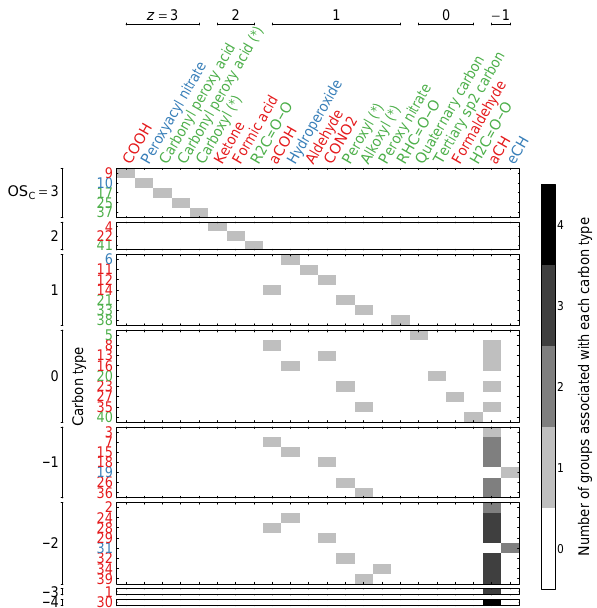
Figure 2. Visualization of the carbon type matrix (cid:50) for the APIN mechanism. Radical groups are denoted with (*). Carbon types and FGs are ordered by their aerosol abundance (in decreasing order) in the APIN simulation at t max SOA (Sect. 2.1) with each value of OS C and z , respectively. The numeric label for carbon types indicates the overall rank (without regard for its OS C ) in the APIN simulation at t max SOA . Formaldehyde and formic acid are subclasses of alde- hyde and COOH, respectively, but are defined separately to fulfill the conditions described in Supplement Sect. S1. Further details re- garding the FG definitions are provided by Ruggeri and Takahama (2016). FGs belonging to measured subset J ∗ = Set1 (Sect. 2.3) is colored in red; additional FGs belonging to Set2 and Full are col- ored in blue and green, respectively. Corresponding carbon atoms C ∗ that are associated with (i.e., detectable by) J ∗ are shown in the same